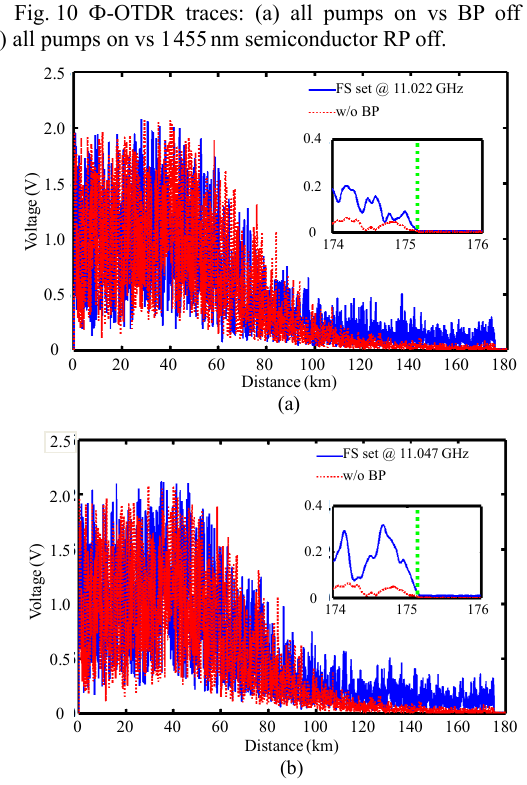
Fig. 11 Ф -OTDR traces: (a) BP frequency shift at 11.022 GHz vs without BP; (b) BP frequency shift at 11.047 GHz vs without BP. Insets: comparison of the signal inside the fiber and the noise outside the fiber.